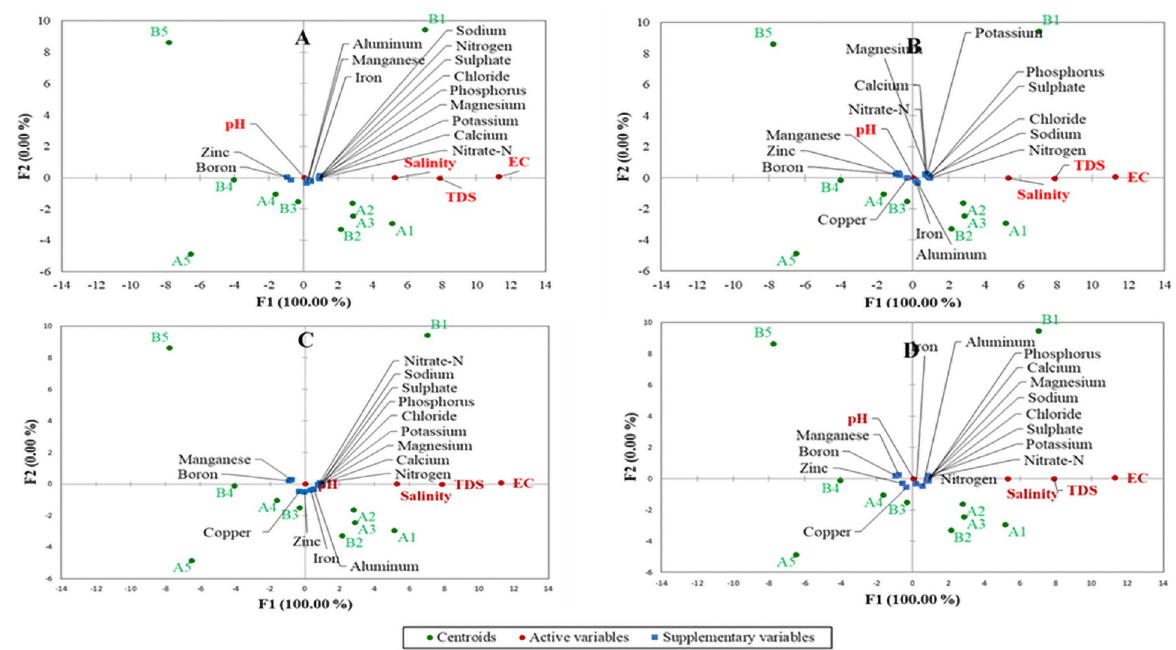
Fig 5. Two-dimension redundancy analyses of growing media nutrient availability and nutrient release as determined using electric conductivity (EC), total dissolved solids (TDS), salinity and pH. A1, B1: 80%vermicast+20%sawdust; A2, B2: 60%vermicast+40%sawdust; A3, B3: 40%vermicast+60%sawdust; A4, B4: 20%vermicast+ 80%sawdust; and A5, B5: sawdust alone. n = 3 per experimental replicate. https://doi.org/10.1371/journal.pone.0254188.g005 PLOS ONE | https://doi.org/10.1371/journal.pone.0254188 July 8,